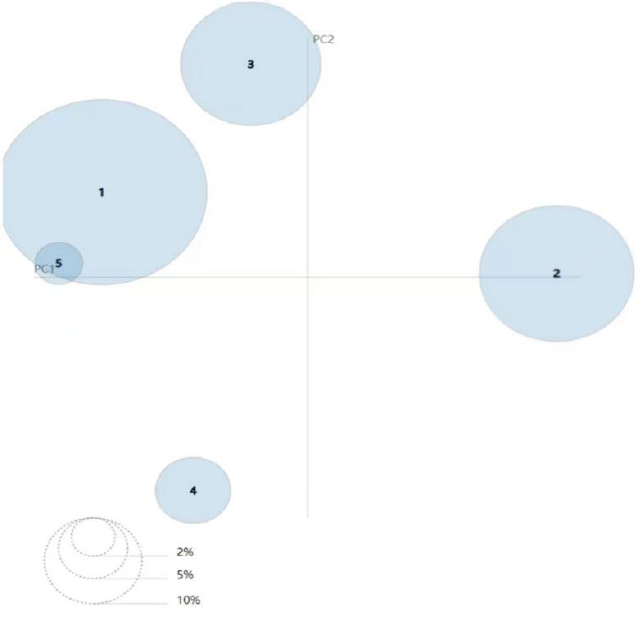
Figure 5. LDAvis visualization results.